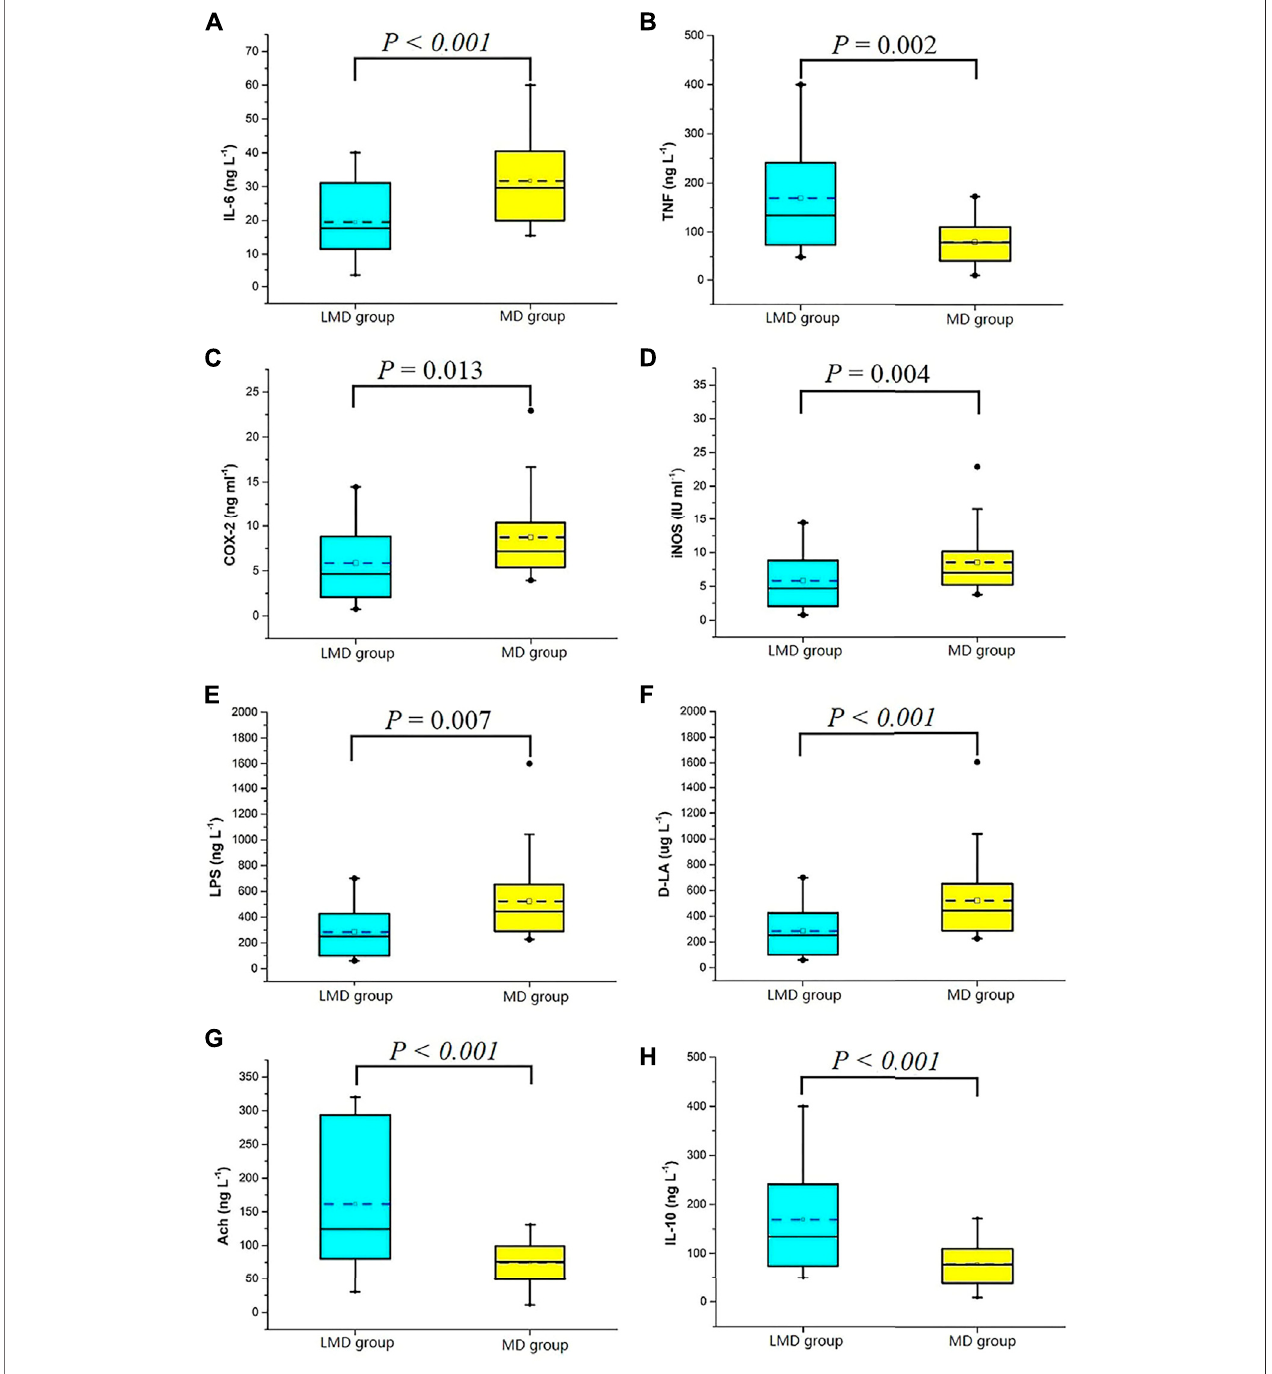
FIGURE4 | Serological indexes 24 h after theoperation. (A) IL-6, interleukin-6; (B) TNF, tumor necrosis factor; (C) COX-2, cyclooxygenase-2; (D) iNOS, inducible nitric oxide synthase; (E) LPS, lipopolysaccharide; (F) D-LA, D-lactate; (G) Ach, acetylcholine; (H) IL-10, interleukin-10.